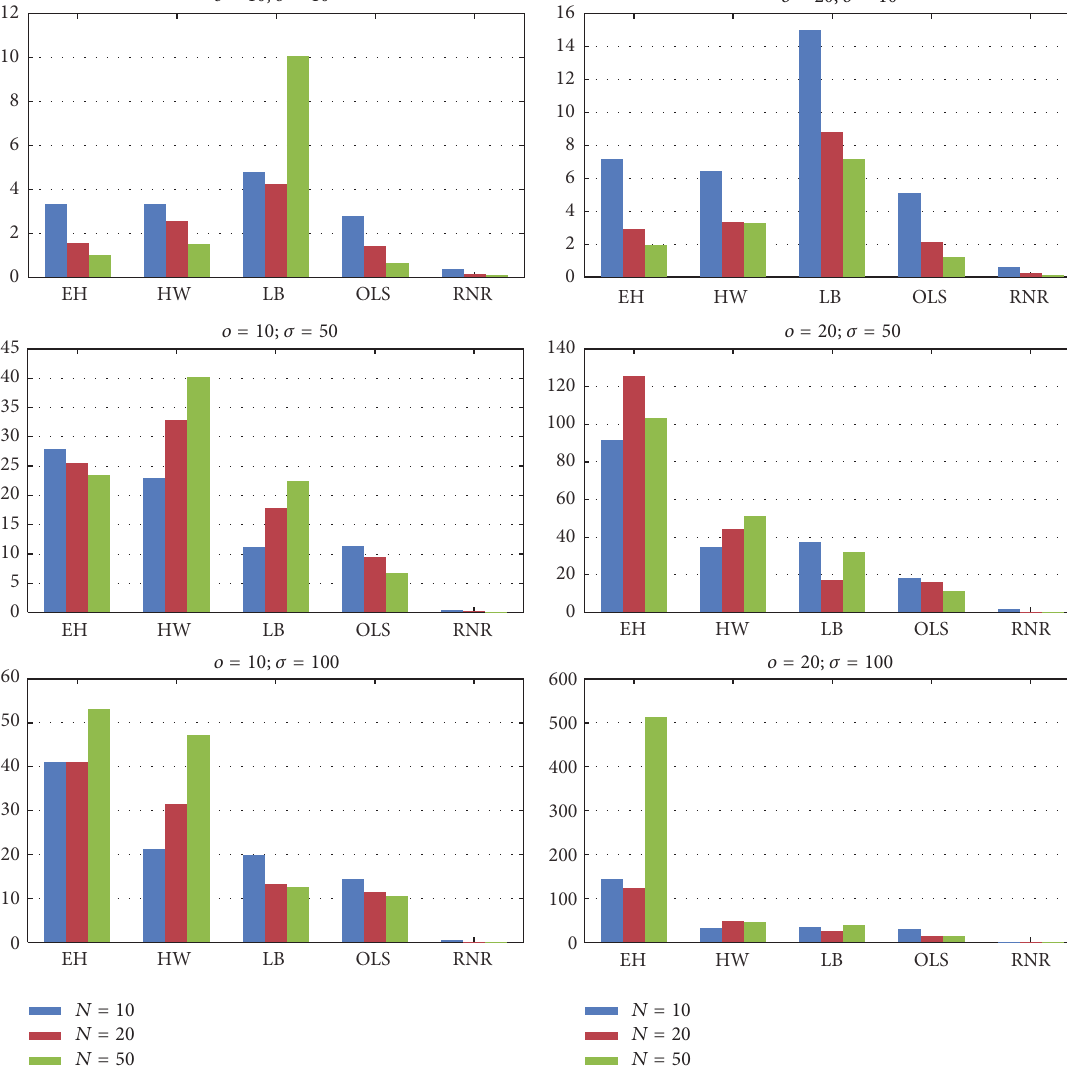
Figure 3: Normalized mean square error of 𝐾 𝑚 for different